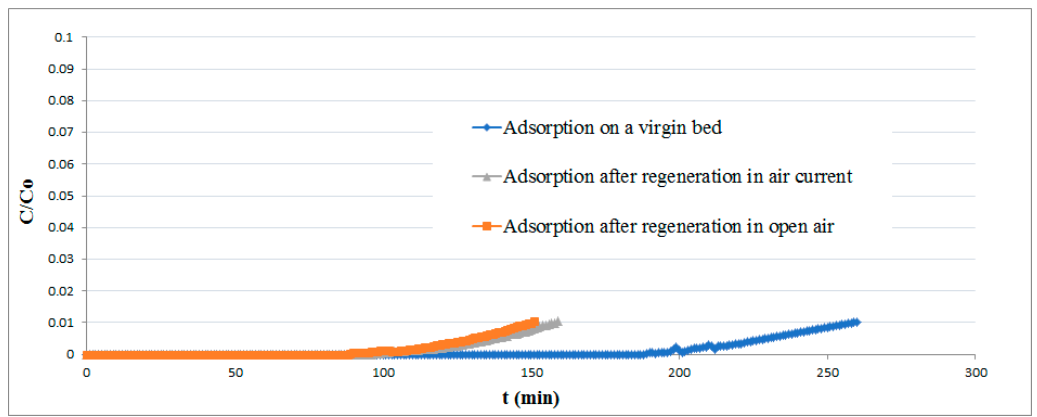
Figure 9. Breakthrough curves for the virgin and regenerated adsorbent.